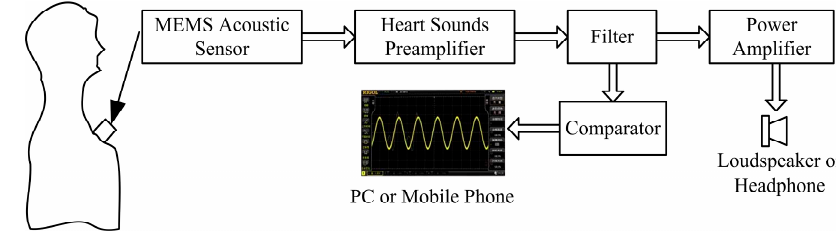
Figure 1. Overall system of the MEMS electronic heart sound sensor.